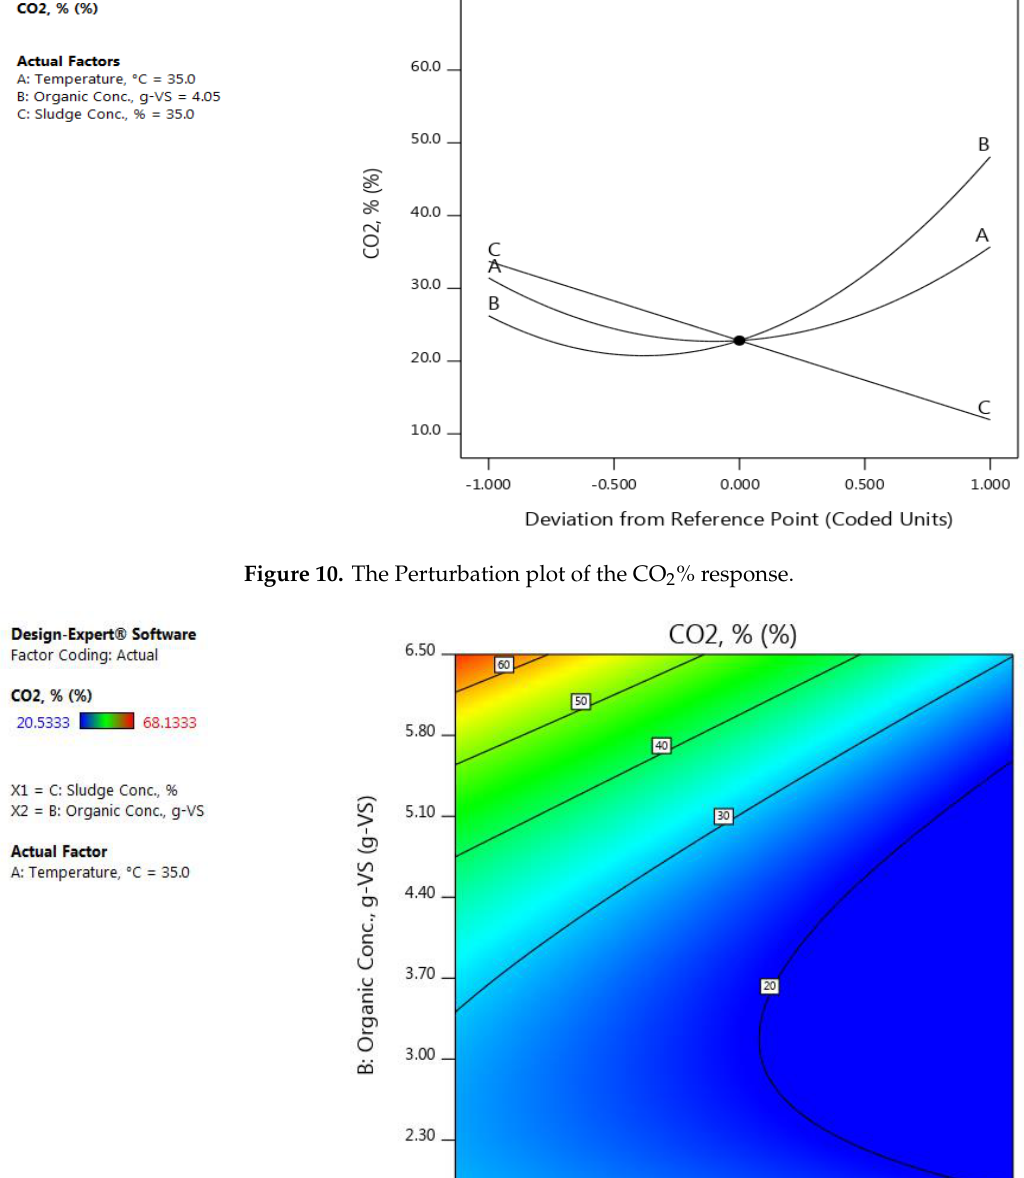
Figure 12. An interaction plot shows the influence of the BC interaction on the CO 2 %. 3.2. The Influence of Starch on the Quantity and Quality of the Biogas Produced Table 8 illustrates the differences between the actual results of the controls (pre-treated peels with starch) and the predicted results (they are obtained by the RSM at the required conditions) of the substrate after separation of starch. According to the differences between the results of the controls and the predicted results at the same conditions, it is obvious that the effect of starch on the quantity of the biogas was relatively low, while it had a small effect on the quality of the biogas. That